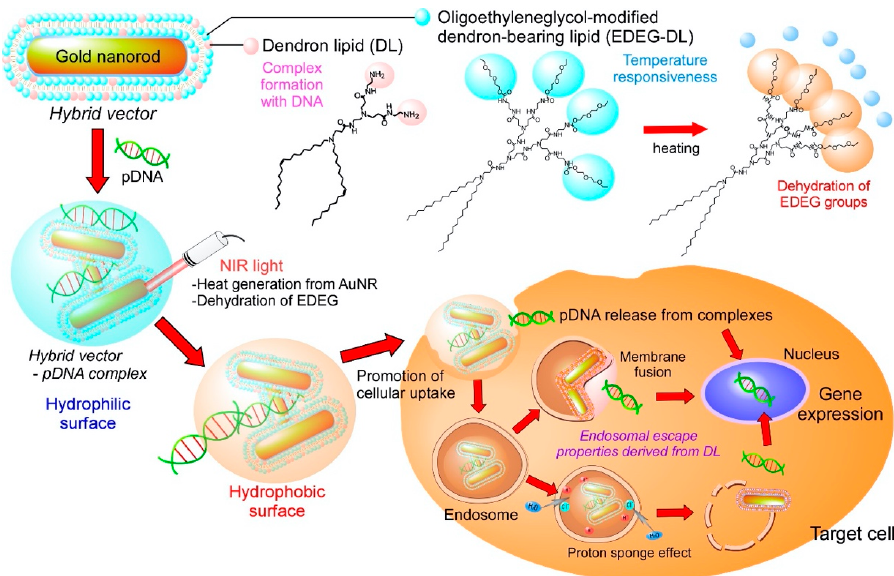
Figure 1. Design of light-activatable transfection system using complexes of pDNA with hybrid vectors composed of gold nanorods (AuNRs) covered with amino group-terminated dendron-bearing lipids (DL) and oligo (ethylene glycol) group-terminated dendron-bearing lipids (EDEG-DL). Amino groups of DL interact with pDNA via electrostatic interaction to form submicrometer-sized complexes. Ethoxydiethylene glycol group-introduced PAMAM G2 dendron-bearing lipid (EDEG-DL) possesses temperature-sensitivity that changes its surface property from hydrophilic to hydrophobic at high temperature conditions. AuNR absorbs near infrared (NIR) light and converts light energy to heat energy. Generated heat changes the surface properties of complexes, which promotes cellular association of complexes via hydrophobic interaction and release of pDNA into cytoplasm to enhance gene expression only at NIR light irradiated cells or tissues.